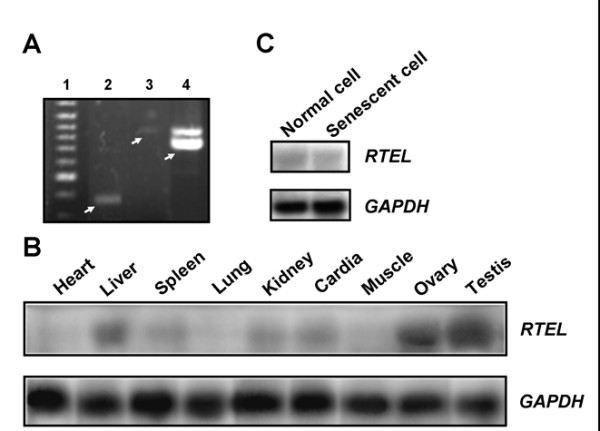
Expression of bovine RTEL. Expression of RTEL in blastocyst. Lines 1 to 4 indicates: marker, GAPDH amplicon, RTEL first round PCR and RTEL second round PCR. GAPDH serves as standard control, arrows highlight the amplification signals. B, C. RTEL expression in indicated adult tissues and cultured cells. A Two kb amplicon of bovine RTEL cDNA and 600 bp of GAPDH were labeled using [32P]dCTP to hybrid to normalized total RNA from multiple tissues and cells. The above panel shows ~4.5 kb hybridization signals of indicated tissues and cells, lower panel shows the ~1.3 kb GAPDH Northern blot signals as standard control.